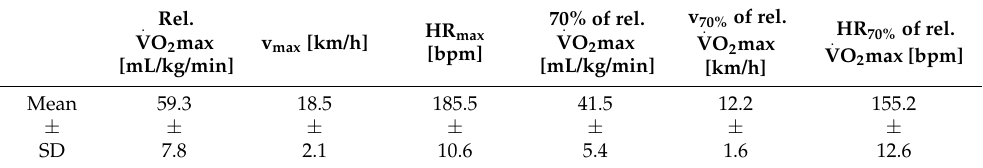
Table 2. Group mean ± standard deviation of the exhaustion test for physiological variables (all subjects).